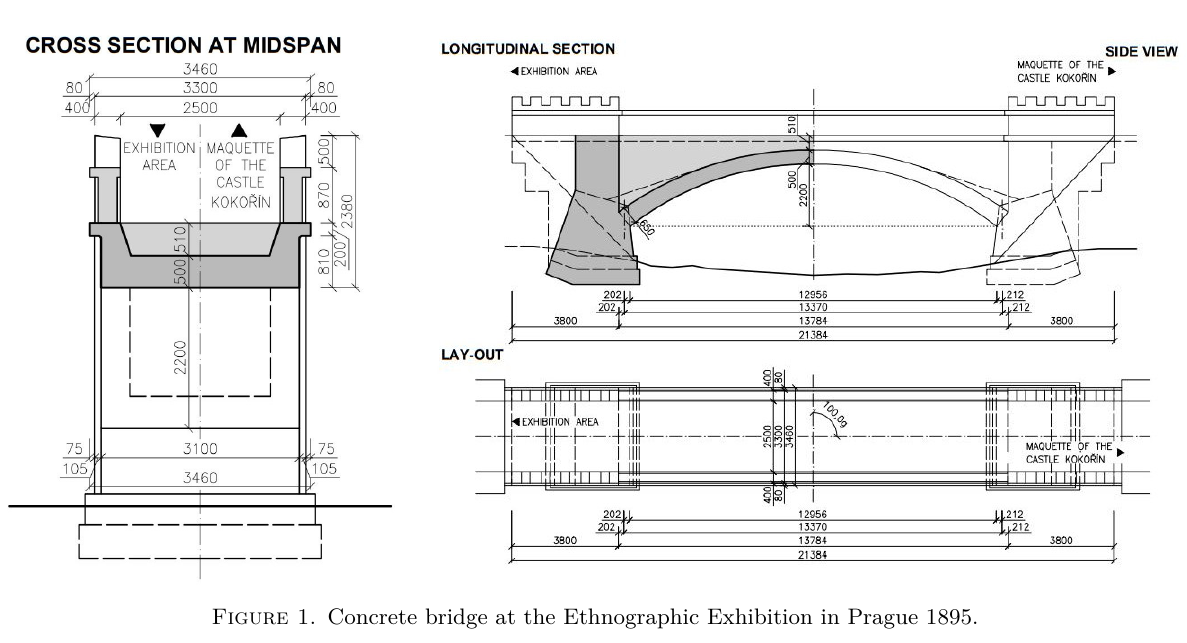
Figure 1. Concrete bridge at the Ethnographic Exhibition in Prague 1895.